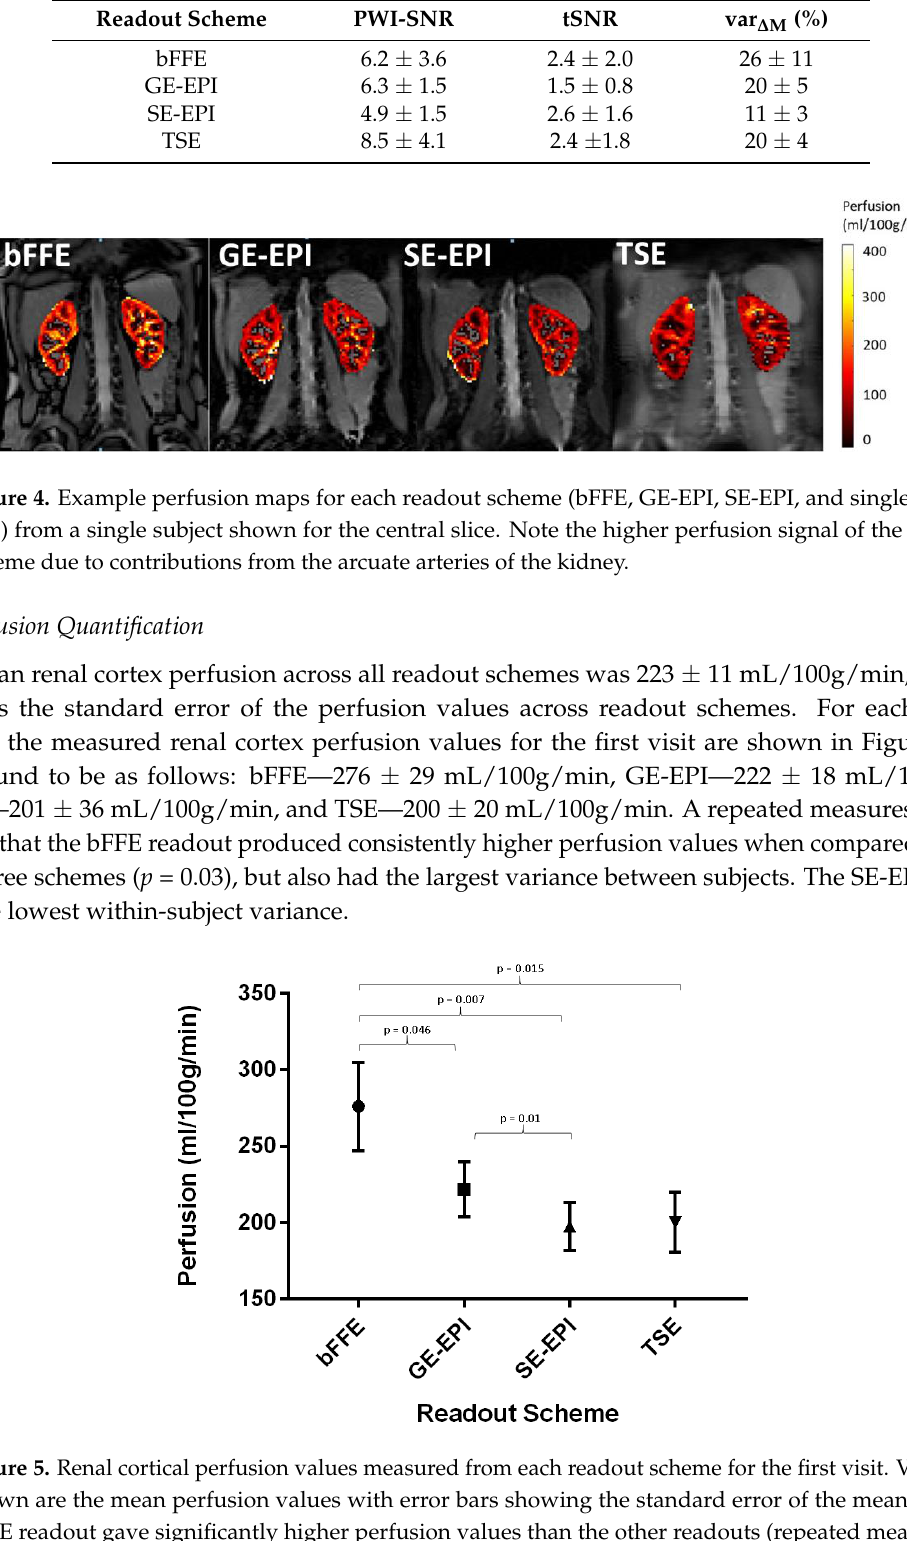
Table 2. Perfusion-weighted image signal-to-noise ratio (PWI-SNR), temporal SNR (tSNR), and variability of the perfusion-weighted signal (var ∆ M ) for each scheme.